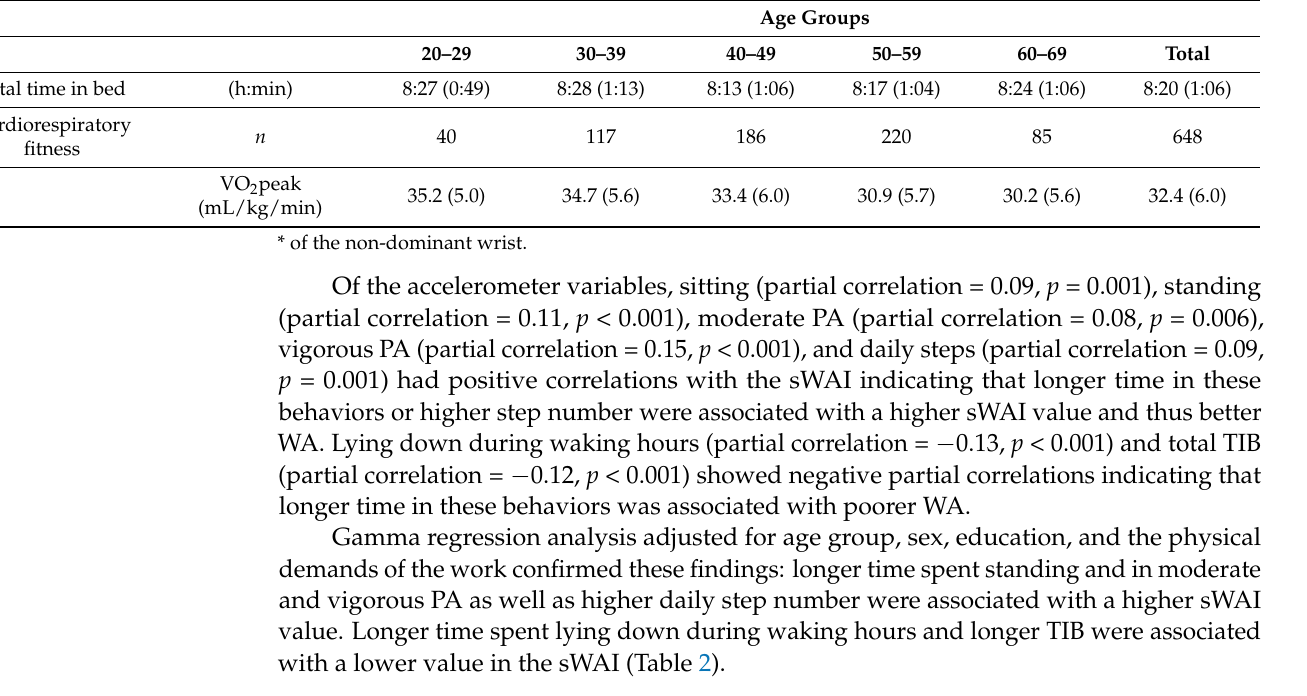
Table 2. Gamma regression on the association between physical behavior, cardiorespiratory fitness, and work ability (sWAI) adjusted for age group, sex, education, and physical work